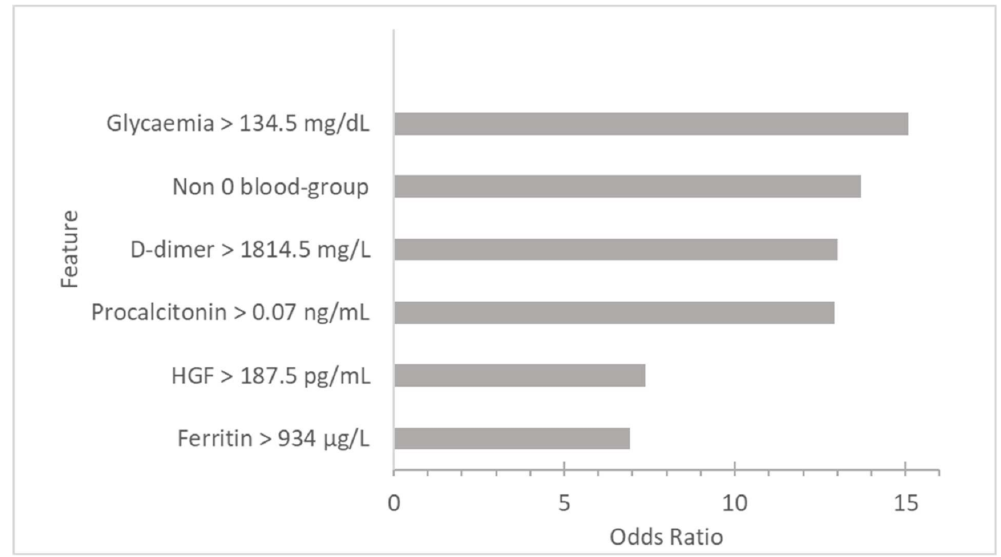
Figure 2. Multivariate analysis showing the contribution of each risk factor to intubation or death